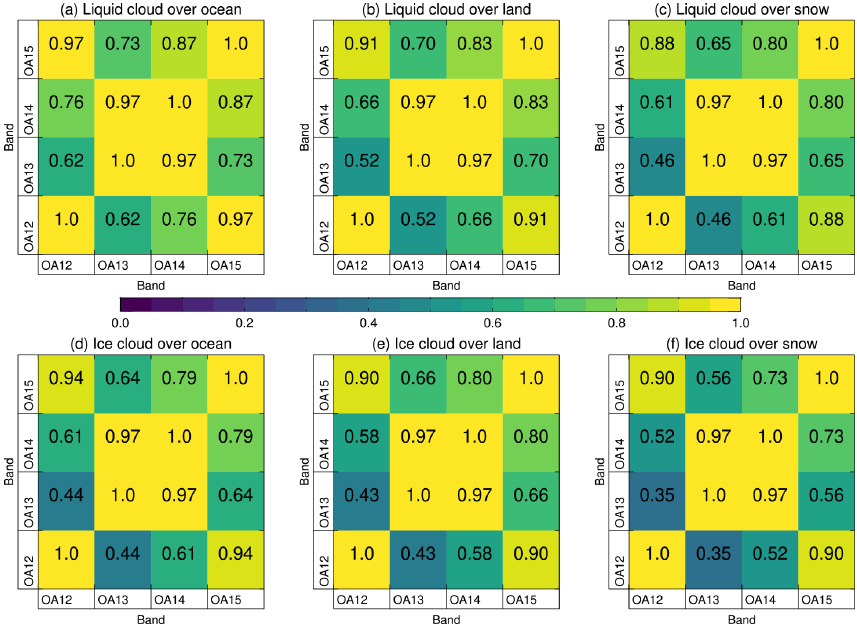
Figure 9. Spectral forward model TOA reflectance uncertainty correlation for OLCI. Panels (a) , (b) , and (c) show results for liquid-phase clouds and (d) , (e) , and (f) for ice clouds. Columns show, from left to right, results for ocean-like, land-like, and snow-like surface albedo respectively. The colour scale and numbers in each grid box (rounded to two significant digits) are equivalent. Nominal central wavelengths for OLCI channels OA12 to OA15 are 753.75, 761.25, 764.375, and 767.5nm